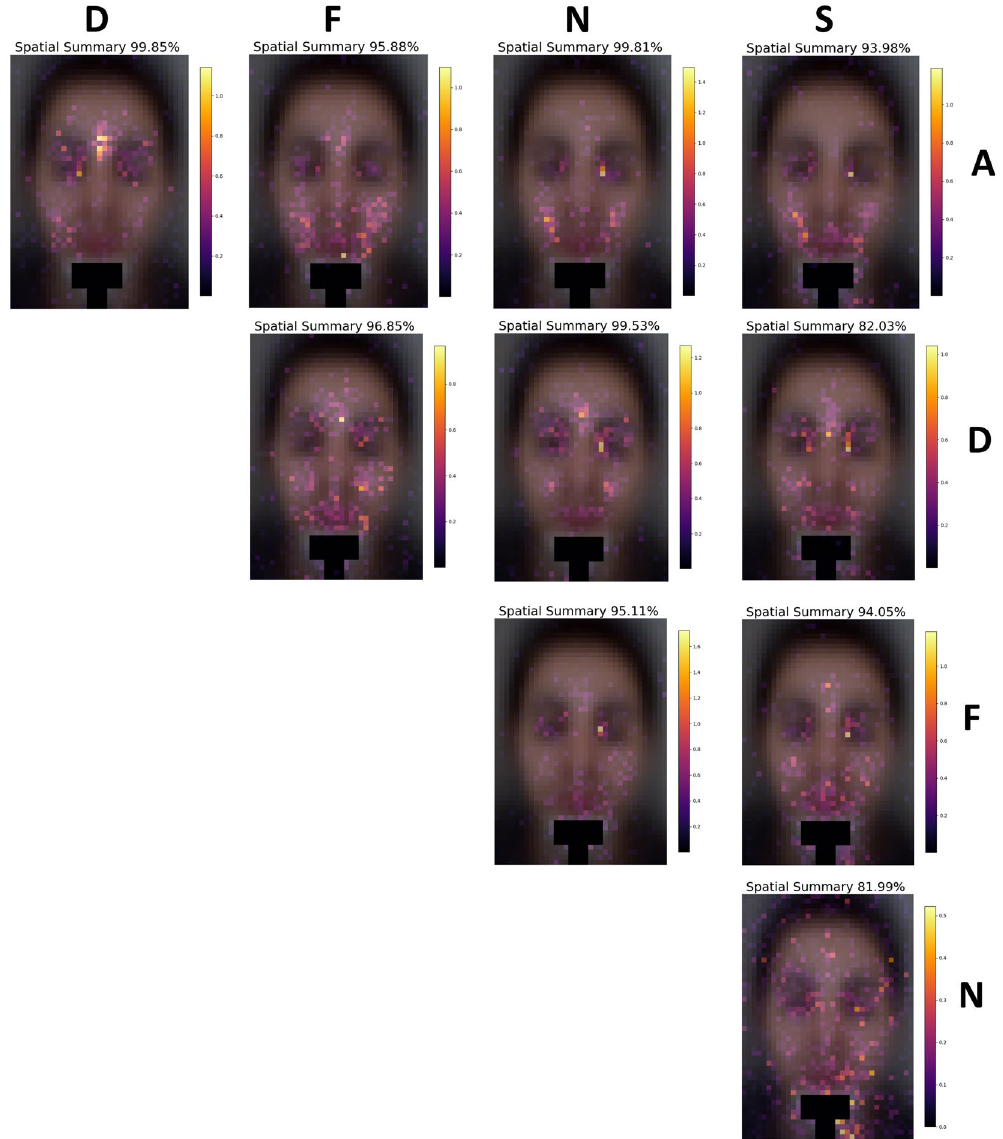
Figure 2. Spatial feature importance maps for 10 binary classifiers are shown, illustrating the different spatial distributions of the significant areas that affect the classification of the various induced emotions. The distributions appear to be sometimes asymmetric, presumably originating in transdermal cardiovascular activity related to the autonomic nervous system (ANS) as described by Liu et al. 27 The overall spatial and temporal summation feature importance percentage for each case is written above each map. Before feeding the TSTMS features into the machine learning classifier, the pixels around the chin were removed from the calculation to eliminate the chin head mount that was used to prevent the participants’ faces from moving during the